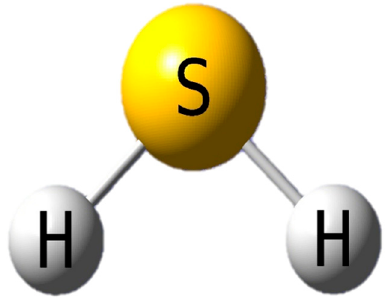
Figure 1. A diagram of C 2v symmetric molecule H 2 S.